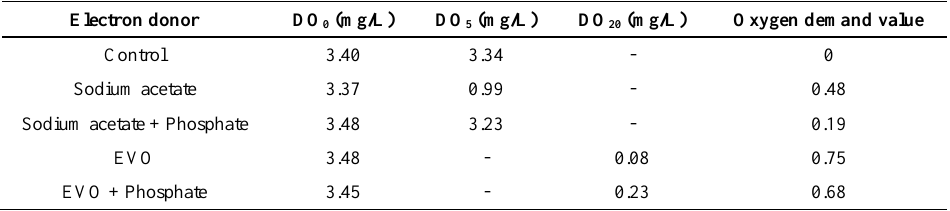
Table 5. Microcosm study results of site A's indigenous bacteria oxygen demand from different electron donors